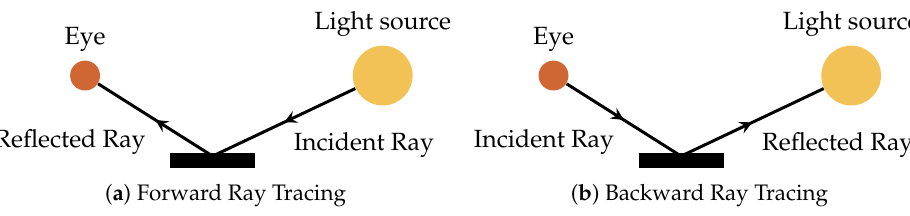
Figure 1. Illustration of backward and forward ray